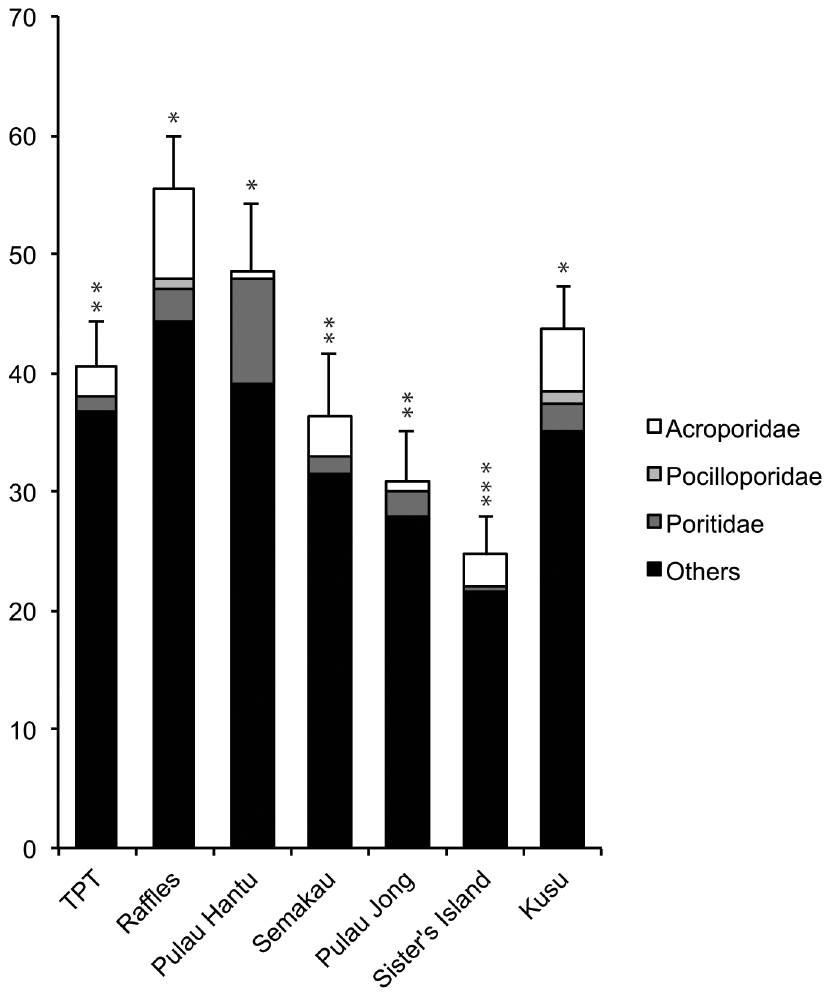
test, p < 0.05). Sites arranged from west to east (see Fig